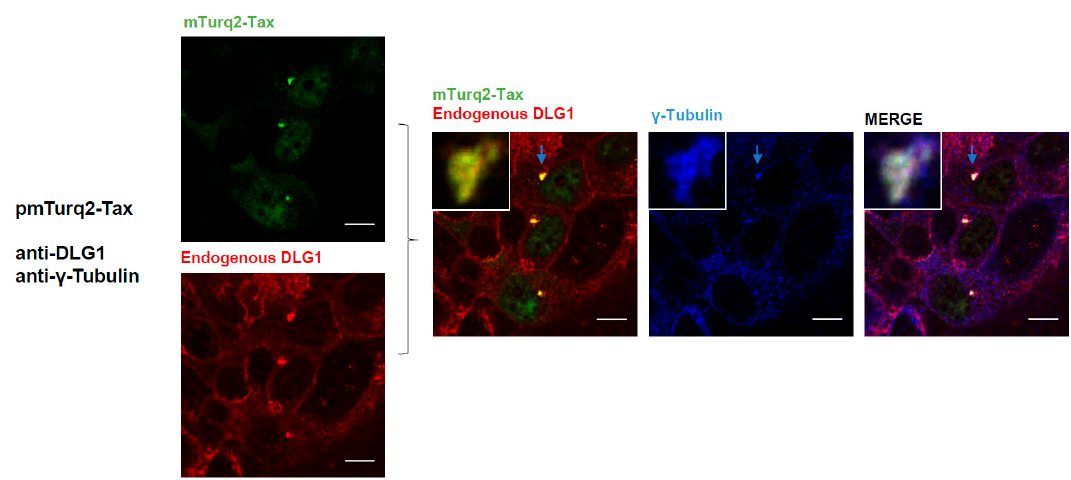
Figure 6. The DLG1-Tax complexes associate with MTOC. HEK293 cells were transiently transfected with mTurq2-Tax (green), and endogenous DLG1 (red) and γ -tubulin (blue) were detected using specific antibodies. The DLG1-Tax- γ -tubulin triple co-localization is shown in white. The light blue arrow indicates the triple co-localization region which is amplified in the inset. All scale bars are 10 µm.